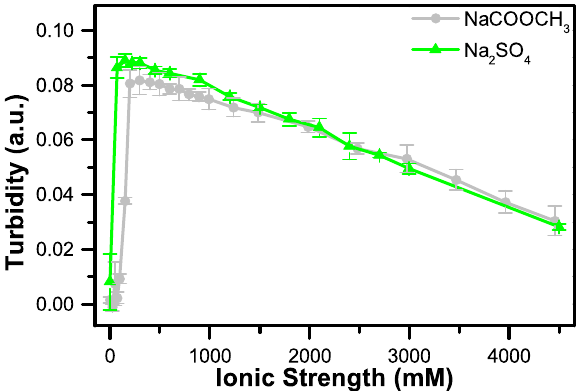
Figure 5. Plot of turbidity as a function of ionic strength, showing a comparison between NaCOOCH and Na SO . All samples were prepared at 1 mM total monomer 3 2 4 concentration, 50/50 mol% pAA/pAH ratio at pH 6.5. Complexes were prepared by adding pAA to a solution containing a mixture of pAH and the desired quantity of salt.